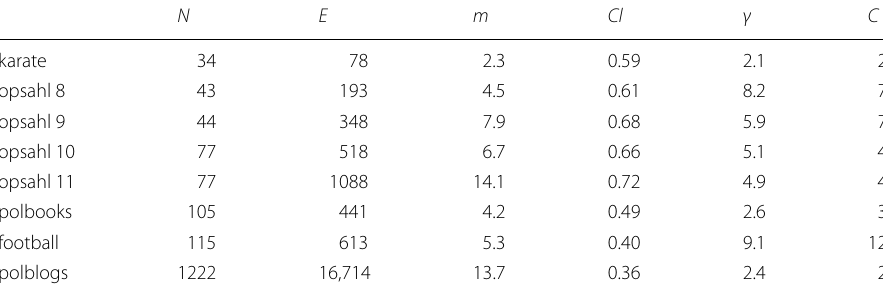
Table 1 Statistics of real